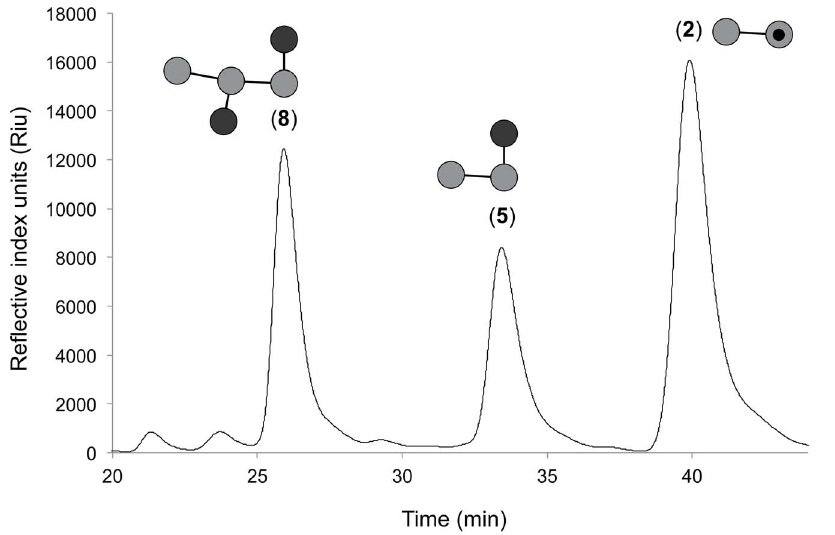
Figure 6. End products from exhaustive hydrolysis of locust bean gum by SACTE_2347 determined by HPLC. The three major products identified by comparison of elution times with purified commercial standards were 1 G, 2 G-M3 ( 8 ), 1 G-M2 ( 5 ), and M2 ( 2 ).